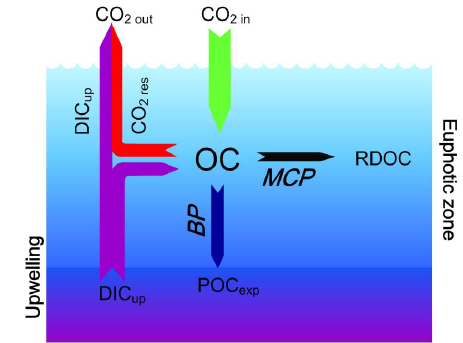
Fig. 8. A diagram showing the factors influencing CO 2 dynamics in an upwelling area. CO 2in : CO 2 dissolving into the sea from atmo- sphere; CO 2out : CO 2 released from the ocean; OC: organic carbon; RDOC: refractory dissolved organic carbon which could stay in the water column for long-term storage; POC exp : particulate organic carbon exported out of the euphotic zone; DIC up : dissolved inor- ganic carbon in the upwelled water, which can be further released into the atmosphere when conditions permit; CO 2res : CO 2 from res- piration. See the text for further details. It is also shown that carbon sequestration takes place through the BP and MCP in an upwelling area even if it is